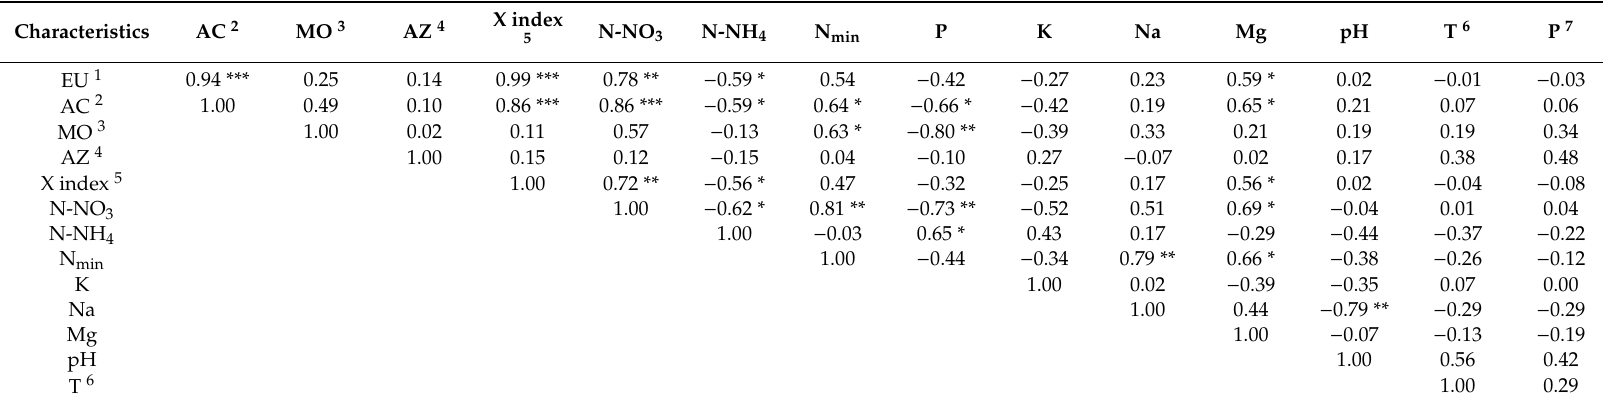
Table A4. Pearson correlation matrix between microbiological and chemical characteristics of pasture soil under mowed system, n = 12.